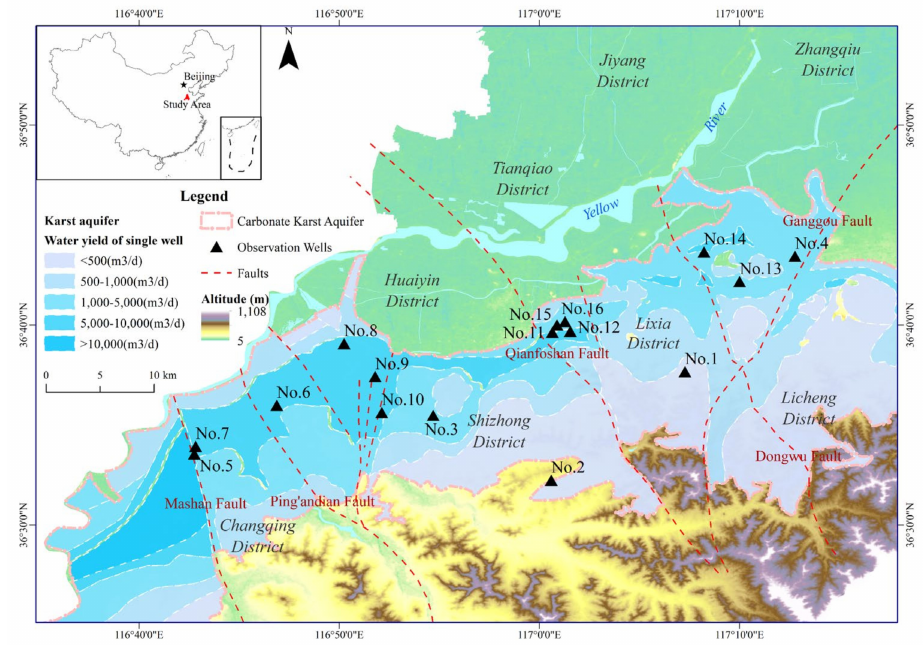
Figure 1. The division of karst water systems and locations of observation wells in Jinan spring